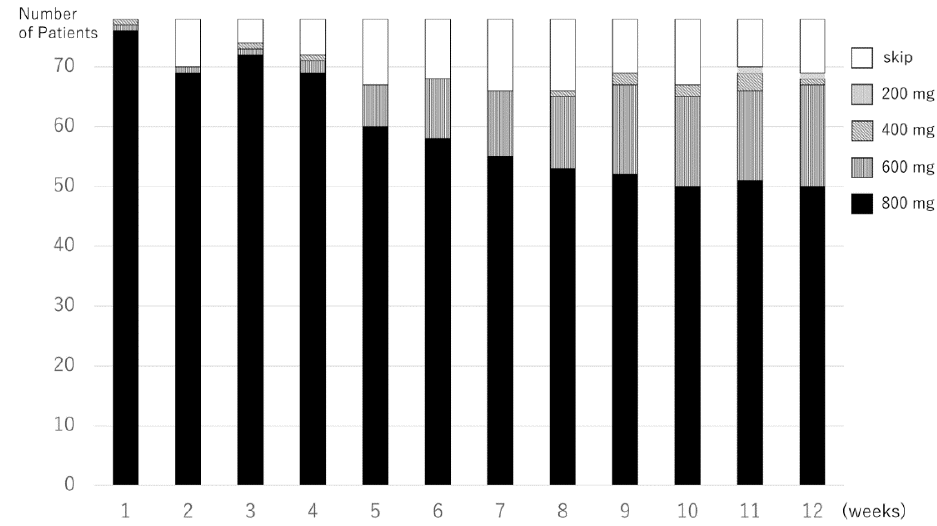
Figure 3. Pazopanib treatment doses in every week of the initial 12 weeks in the pazopanib responders.